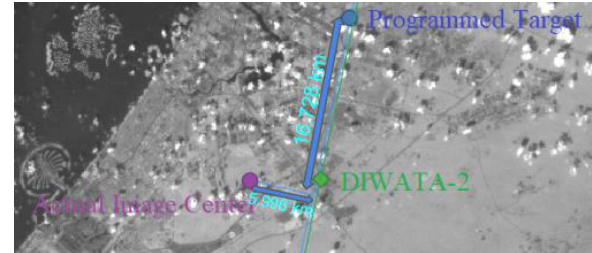
Figure 7. Dubai, UAE. Distance from programmed target to actual image center.